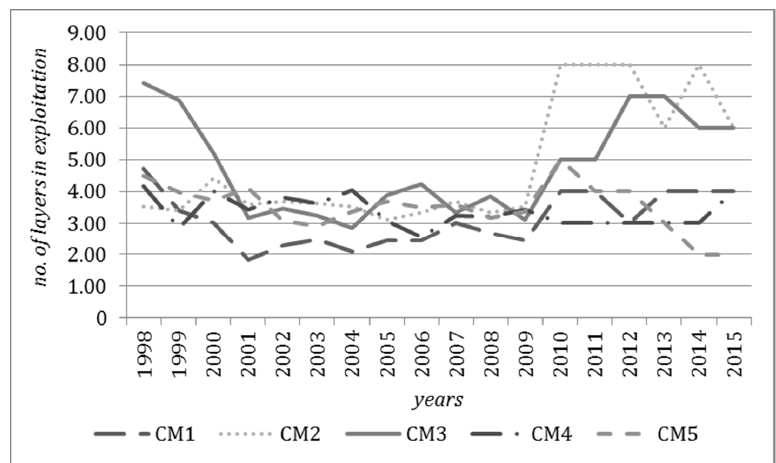
Figure 12. Number of layers in exploitation in examined hard coalmines over the period 1998–2015. Source: own work.